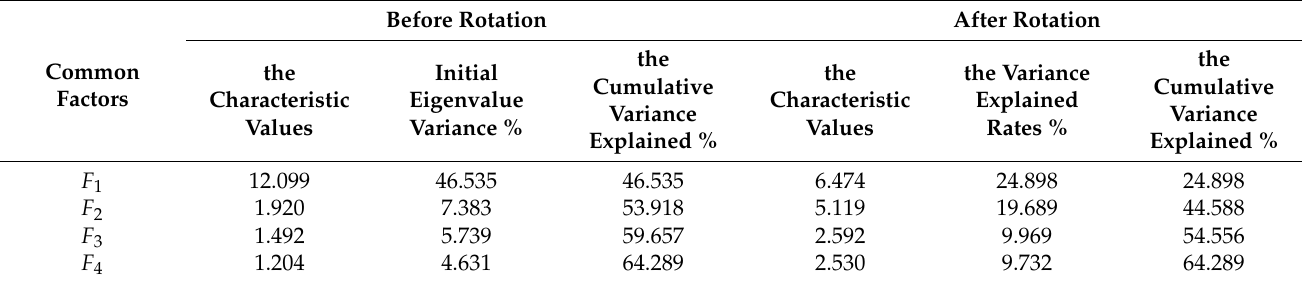
Table 5. Eigenvalues and explained